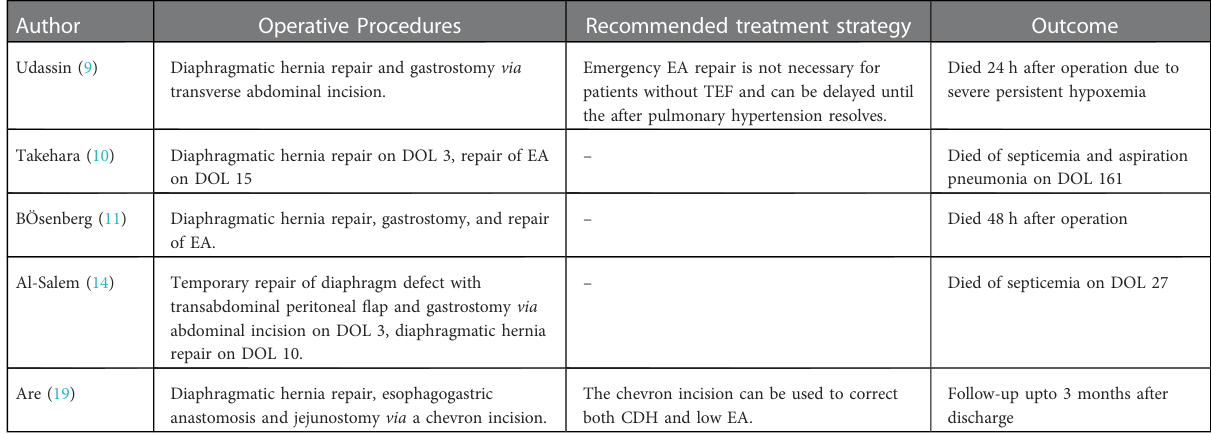
TABLE 4 Summary of treatments of left CDH associated with